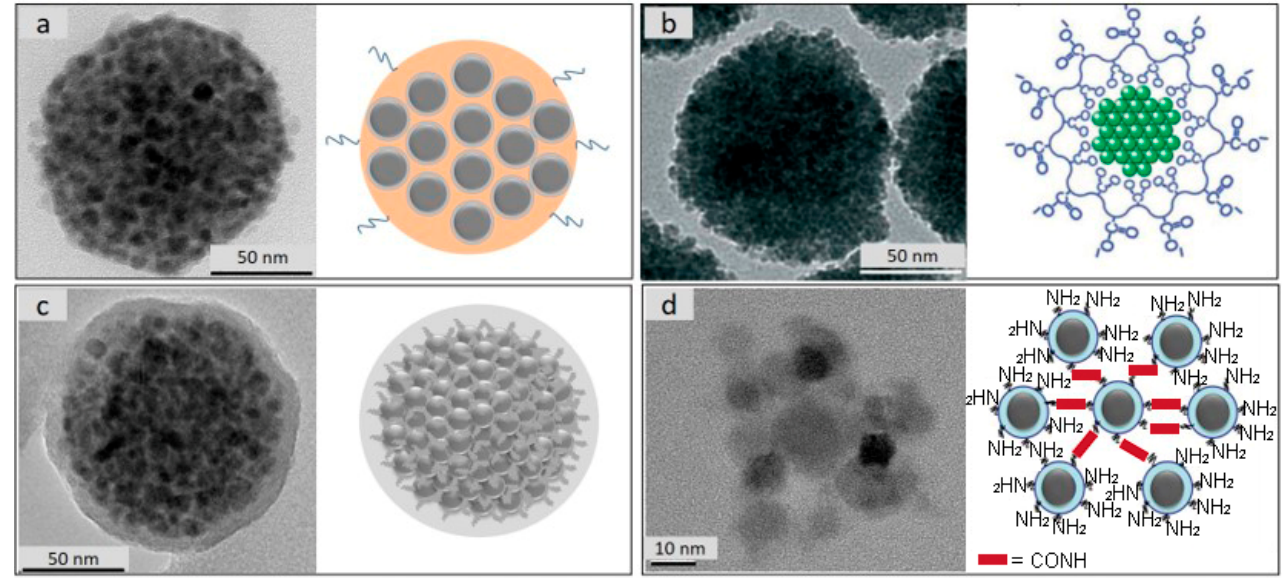
Figure 6. TEM images and corresponding schematic illustrations of synthesized magnetically guidable nanoparticle clusters. ( a ) Composite magnetic nanoparticle cluster composed of superparamagnetic maghemite nanoparticles and biocompatible polymer [85] ( b ) One-pot solvothermal synthesis of clusters composed of many superparamagnetic magnetite nanoparticles. Adapted with permission from [84] Copyright 2007, with permission from Wiley. ( c ) Emulsion/evaporation-based clustering of hydrophobic maghemite nanoparticles following silica coating. Reprinted from [29], Copyright 2014, with permission from Elsevier. ( d ) Chemical cross-linking method of differently functionalized superparamagnetic maghemite nanoparticles forming synthesized magnetically guidable nanoparticle cluster, adapted from [42]. CC BY 4.0